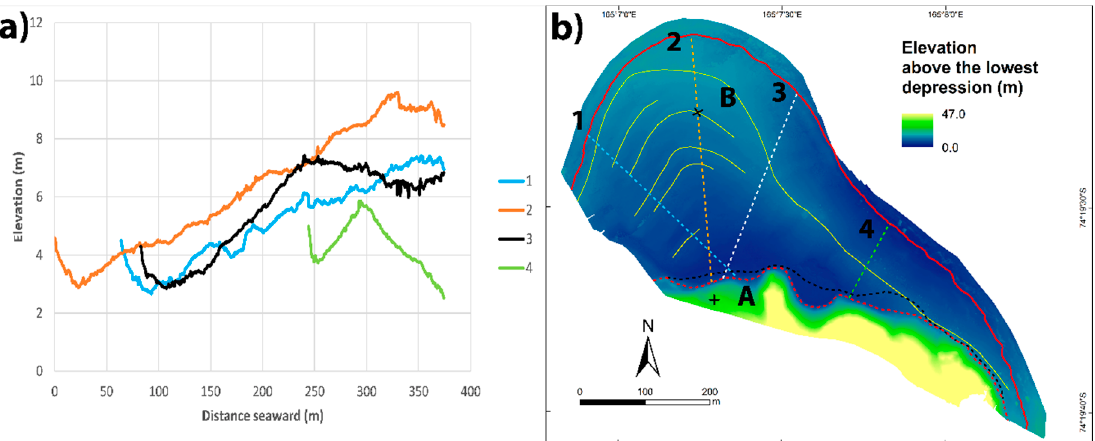
Figure 8. Four elevation profiles from the coastline to the upper beach limit crossing the beach ridges. ( a ) elevation profiles from the coastline to the upper beach limit, ( b ) location of the profiles on the DEM of the beach. “A” and “B” indicate the starting and ending point of the electrical resistivity tomography (ERT) showed in the Section 4.3. For other symbols refer to Figure 2. Please note that profile 1–3 are lower than the significant wave height (1.95 m) when considering the range between the coastline and the top of the main beach ridge.